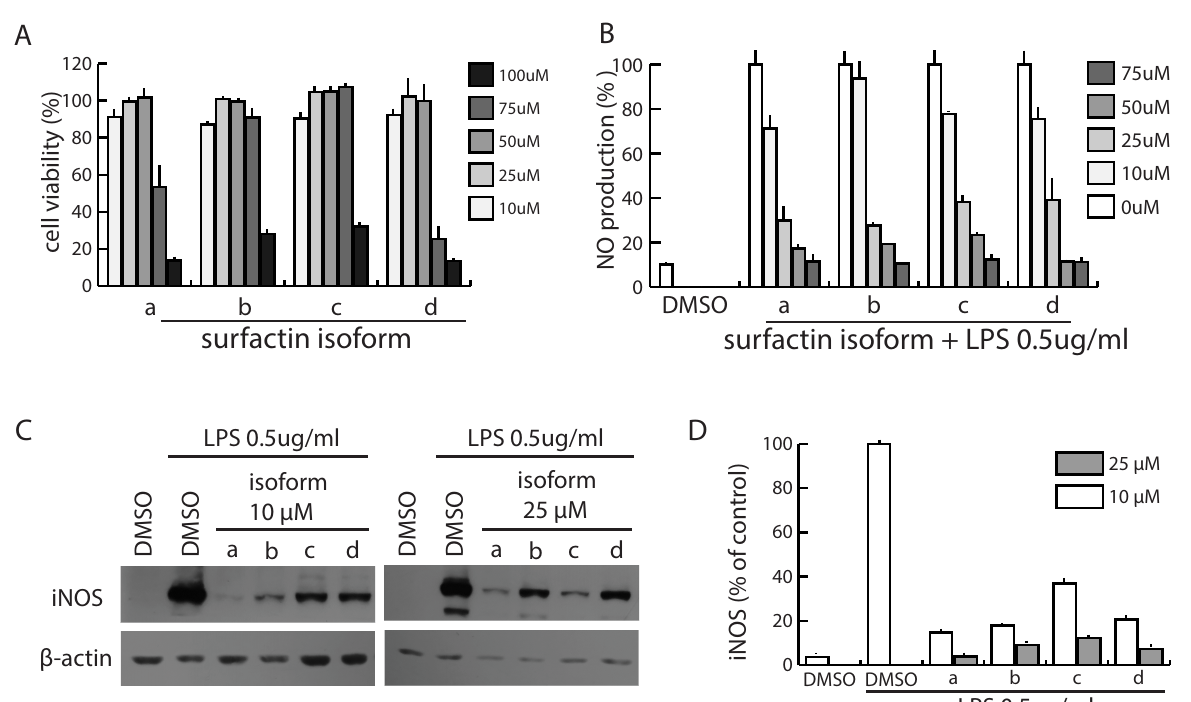
Fig 5. Suppression of nitric oxide (NO) production by surfactin. A. Effect of surfactin isoforms a, b, c, and d on the viability of macrophage cells, RAW 264.7. B. Effect of surfactin on NO production. C. Western blot results showing suppression of the inducible NO synthetase (iNOS) by each surfactin isoform. Lipopolysaccharide (LPS) dissolved in dimethyl sulfoxide (DMSO) is an iNOS inducer. D. Chart showing relative amounts of iNOS. Boxes and bars represent mean and standard deviations.